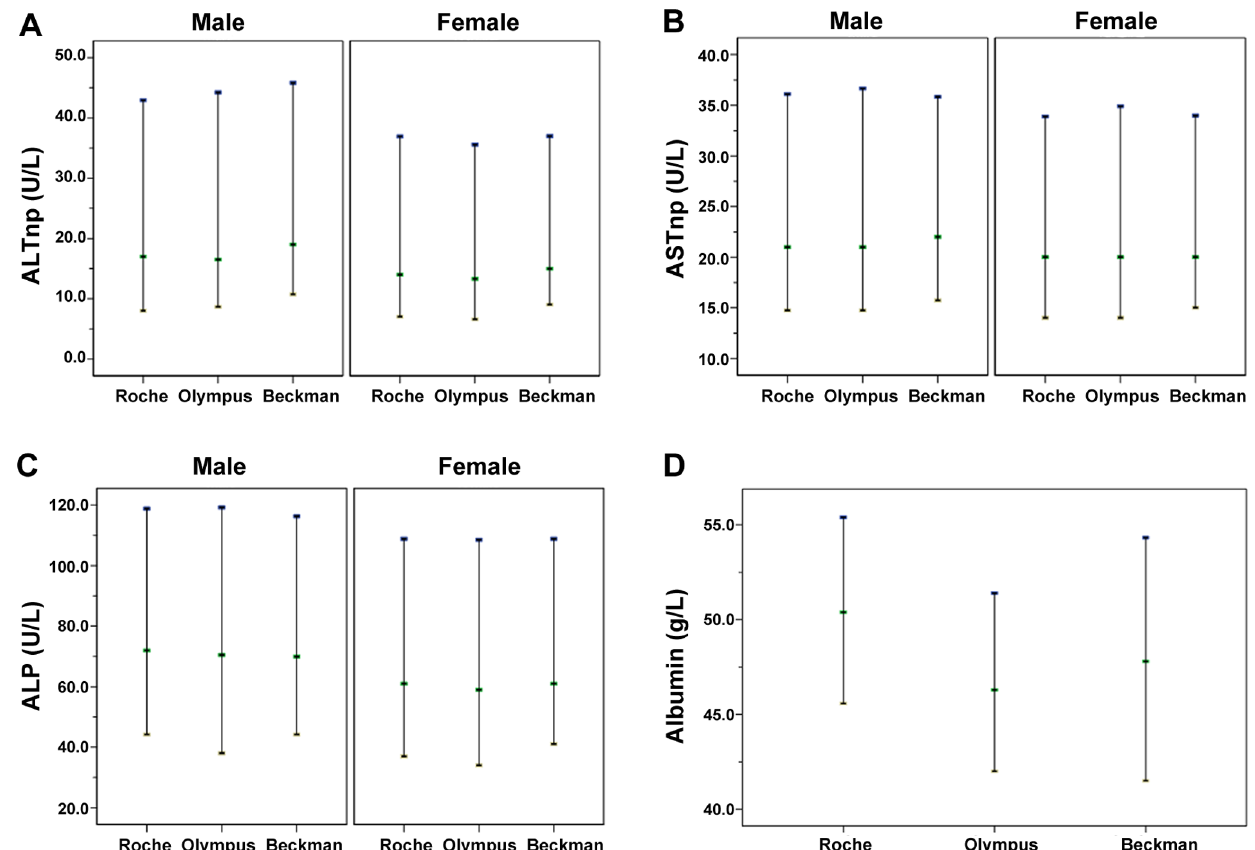
Figure 5. Comparison of the reference intervals of three systems for liver function tests in Shenyang. (A) ALTnp; (B) ASTnp; (C) ALP; (D) Albumin.